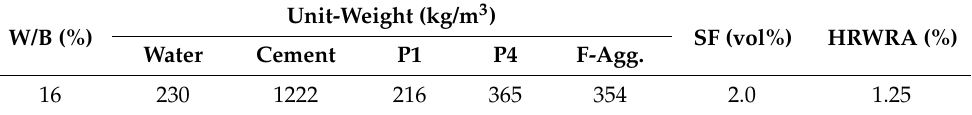
Table 10. Mixture proportion of UHPFRC (for the compressive and flexural strengths test).